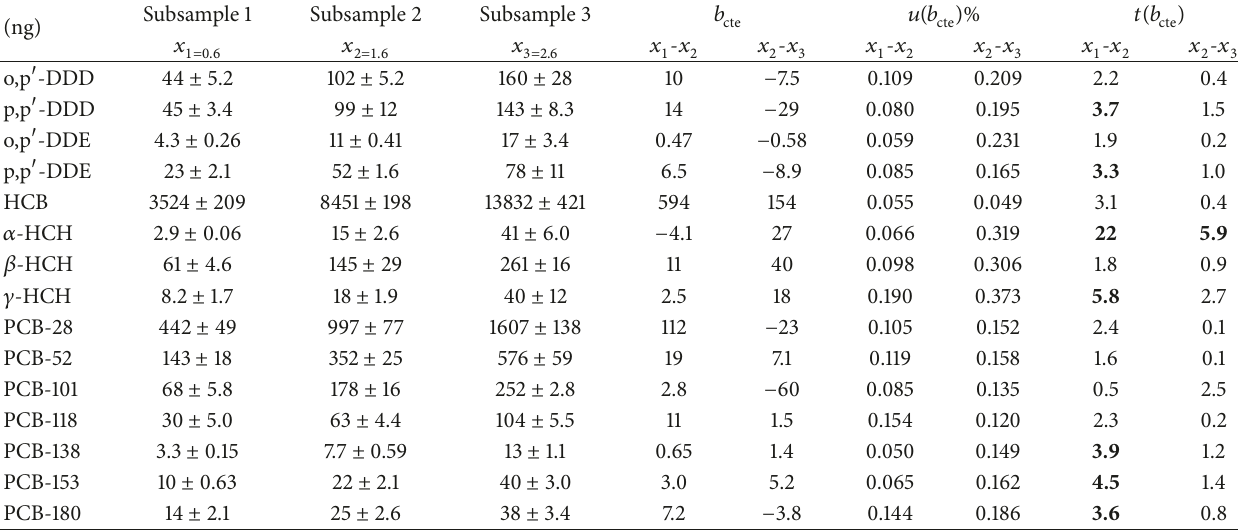
Table 3: Study of constant bias by means the analysis of three sediment subsamples of 0.6, 1.6, and 2.6 grams,